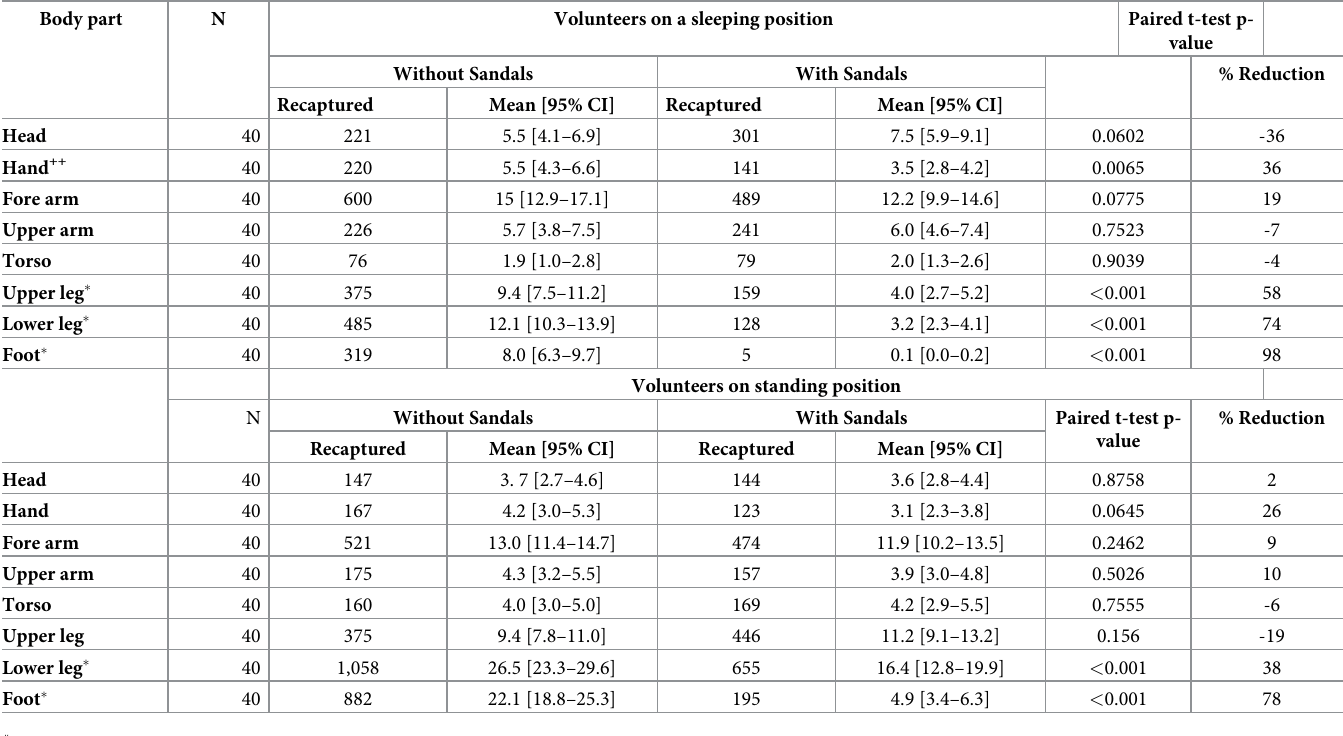
Table 3. Mean number of Aedes aegypti caught at different body parts of volunteers with and without the transfluthrin-treated sandals. Body part N Paired t-test p-